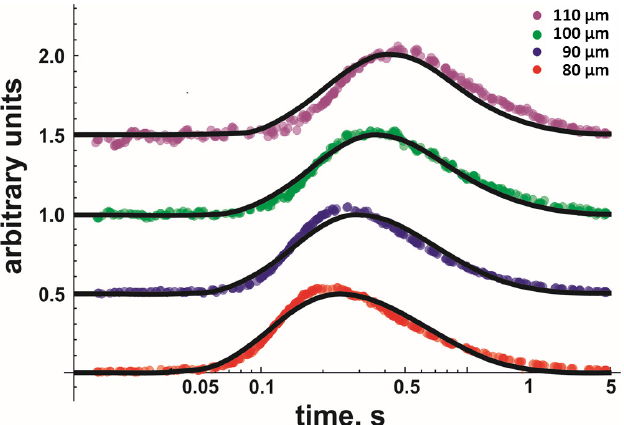
Figure 2. Kinetics of proton concentration changes adjacent to the DOPG membrane surface measured at different distances x from the release spot. The temperature was equal to 19 °C. The representative colored traces represent an average of 20 individual release events. The global fits of the non-equilibrium model (Equation (8)) to all traces measured for the four distances at 19 °C (also to those traces not shown here) are depicted as solid black lines. Data amplitude was normalized to 0.5, and the individual curves were shifted vertically for representational reasons.